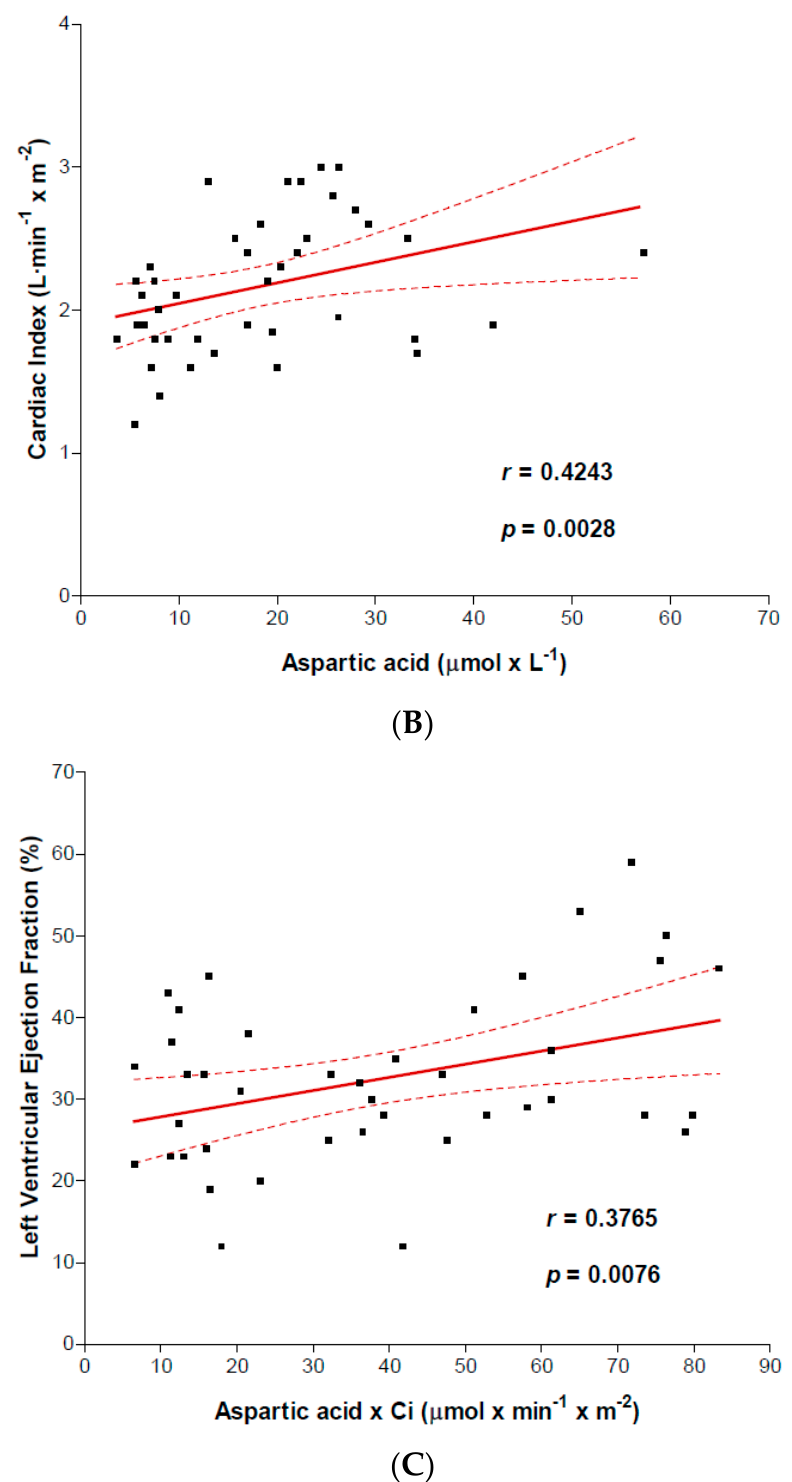
Figure 1. Relationships between arterial aspartic acid and left ventricular (LV) function. Correlation between Aspartic acid and stroke volume index ( panel A ), Cardiac Index ( panel B ). The ( panel C ) shows the correlation between arterial Aspartic acid times cardiac index and left ventricular ejection fraction.